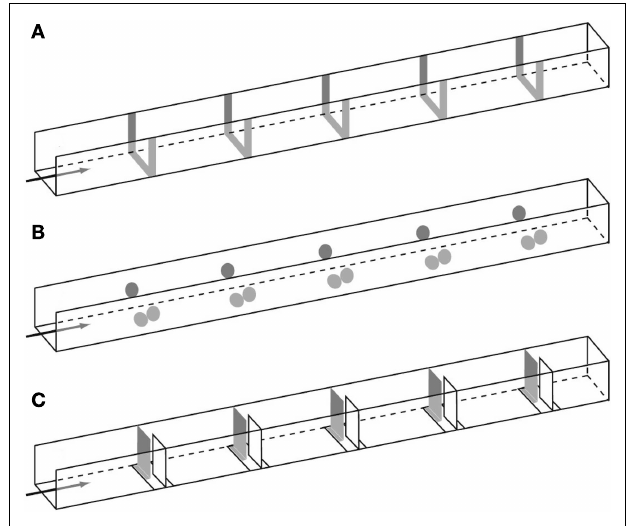
FIGURE 1 | Illustration of the experimental tunnels with landmarks consisting of (A) stripes, (B) circles, and (C) baffles spaced at regular intervals. Adapted with permission from Dacke and Srinivasan